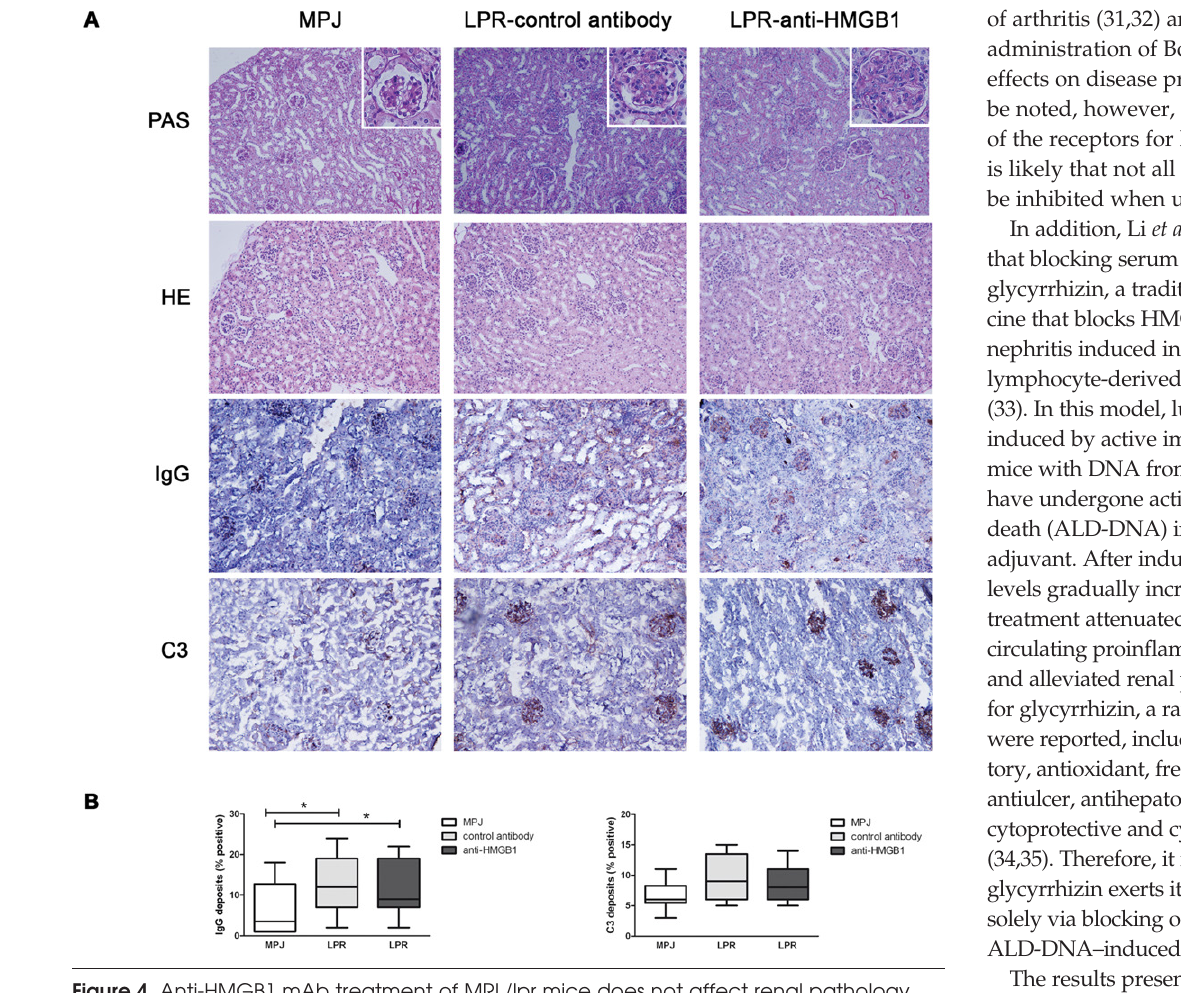
Figure 4. Anti-HMGB1 mAb treatment of MRL/lpr mice does not affect renal pathology and renal immune complex deposition. (A) Representative pictures of PAS, H&E, C3 and IgG staining in kidney sections of 17-wk-old MRL/MPJ and MRL/lpr mice (10×). Inserts show a glomerulus in detail (40×). (B) Quantitative analysis of C3 and IgG deposition in kidney sections of 17-wk-old MRL/MPJ and MRL/lpr mice. Box and whiskers plot, median and interquartile range are shown for n = 8–11 mice per group. A Kruskal-Wallis test was used to test for overall differences between the three groups. To investigate which group was different, further testing was performed to compare groups separately using a Mann-Whitney U test. * p <